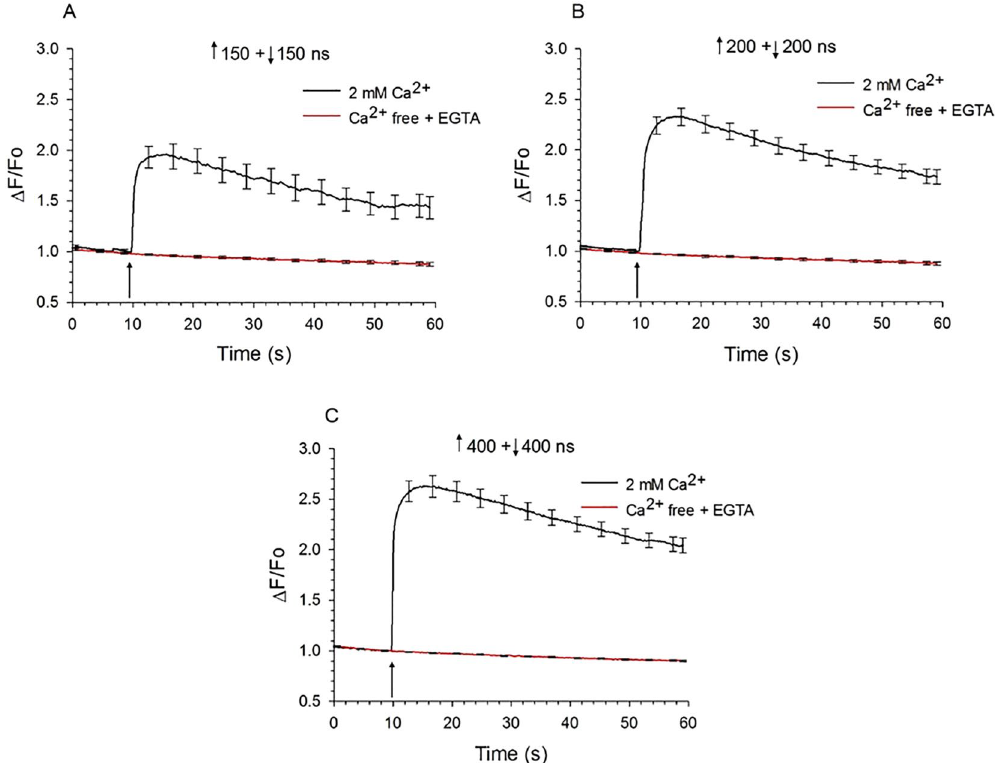
Figure 4. Effect of extracellular Ca 2 + on Ca 2 + responses elicited by symmetrical bipolar pulses. Averaged cell responses ± s.e.m for cells exposed to a ( A ) ↑ 150 + ↓ 150 ns pulse (n = 12–13), ( B ) ↑ 200 + ↓ 200 ns pulse (n = 10–14), and ( C ) ↑ 400 + ↓ 400 ns pulse (n = 6–11). Pulses were applied at an E-field of 3.1 kV/cm to cells in the absence (Ca 2 + -free BSS with 1 mM EGTA) or presence of 2 mM extracellular Ca 2 + . The arrow indicates when the pulse was delivered to the